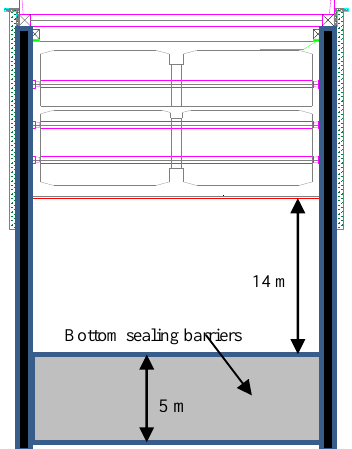
Figure 9. Design of jet-grouted bottom sealing barriers.